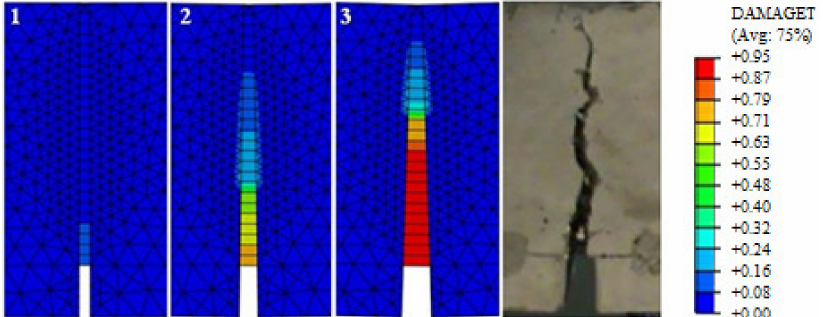
Figure 22. Image of finite element method (FEM) destruction corresponding to the characteristic points of the static equilibrium path (see Figure 18) of SFRHSC beams (series C); the final image of the destruction of the tested C2 beam and the legend for the material damage